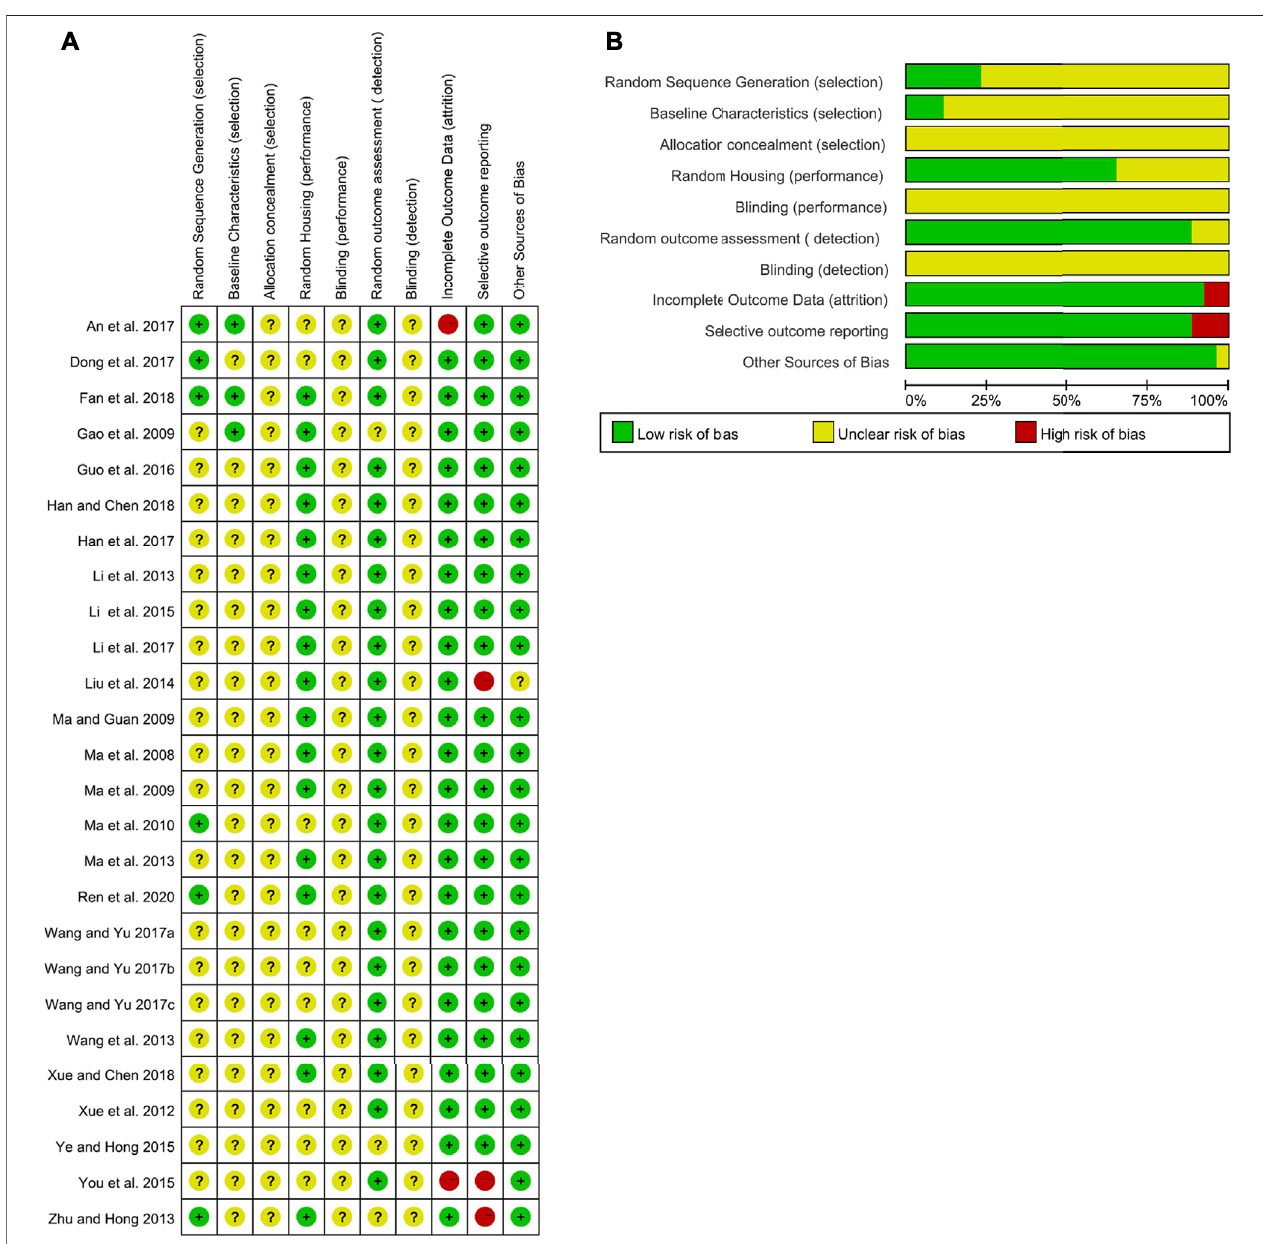
FIGURE 2 | Risk of bias of the included studies. (A) Summary of the risk of bias. (B) Summary of the risk-of-bias assessment.